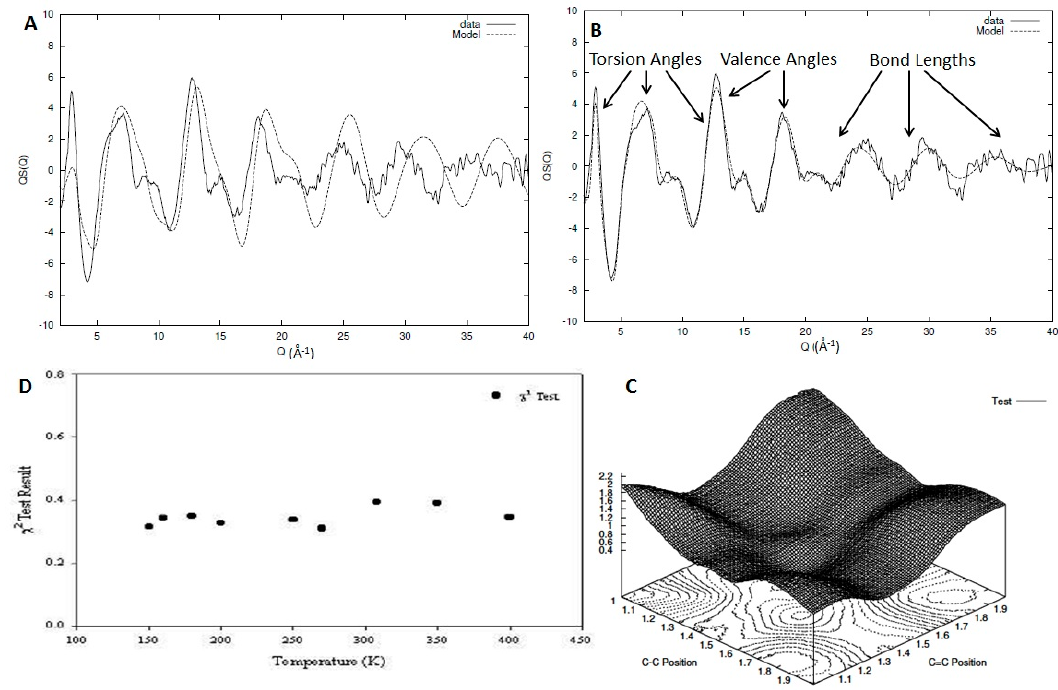
Figure 7. Comparison between the experimentally observed structure factor (solid line) and that calculated from a model (dashed line) for 1,2 polybutadiene at 250 K ( A , B ). In ( B ), the areas where the different structural parameters have the most impact on the structure factor is indicated. In ( C ), a surface plot of the statistical test as a function of the C-C and C=C bond lengths can be seen for a model of 1,4 polybutadiene. In 7 D , the final result of the best-fit statistical test for the different models of 1,2 polybutadiene can be